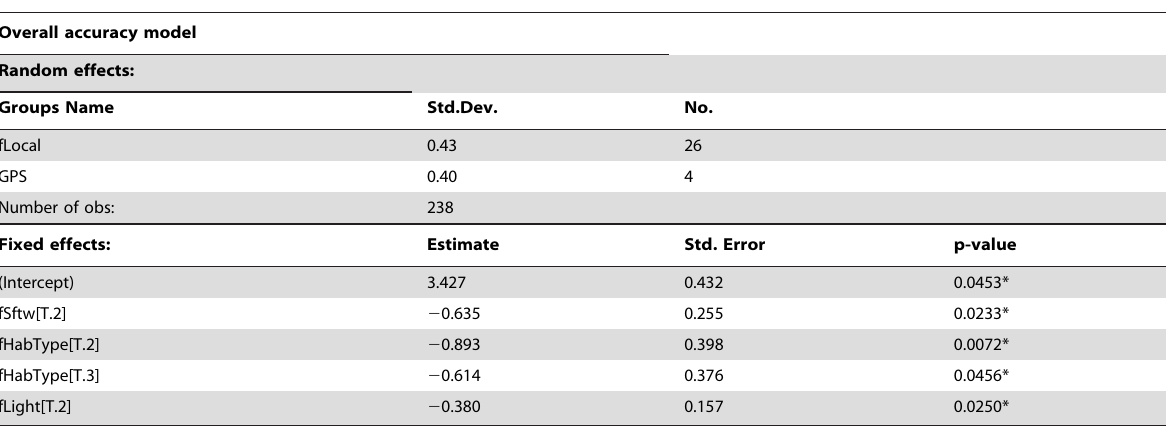
Table 3. Results of the GLMM model to predict GPS Location Error.